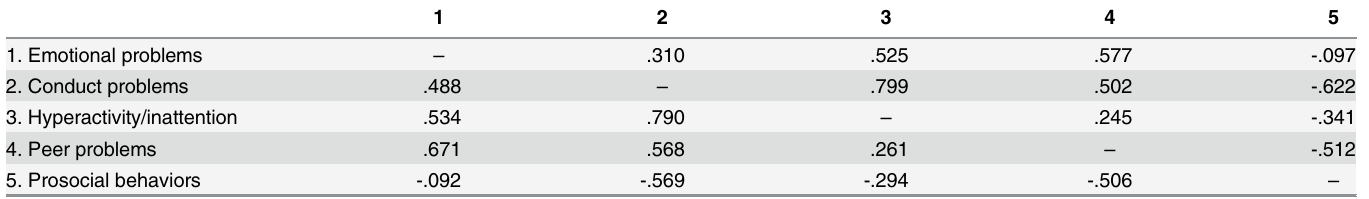
Table 4. Correlations between latent factors of the Strengths and Difficulties Questionnaire for girls (above diagonal) and boys (below